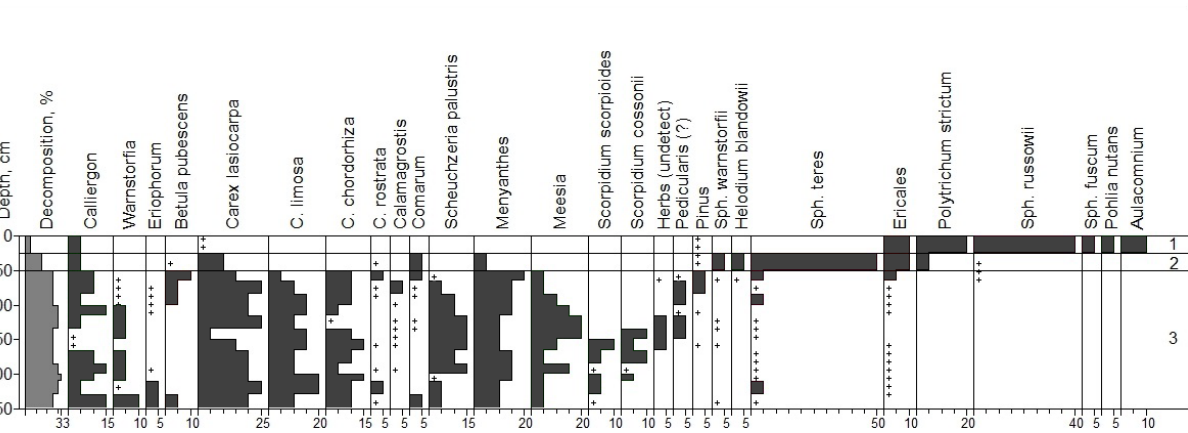
Figure 5. Peat macrofossil diagram for Sample Plot 4 (string; the upper 250 cm). Paleocommunities: 1) Ericales - Sphagnum fuscum + S. russowii; 2) Carex lasiocarpa - Sphagnum teres ; 3) Carex spp. + Menyanthes trifoliata - Bryales.